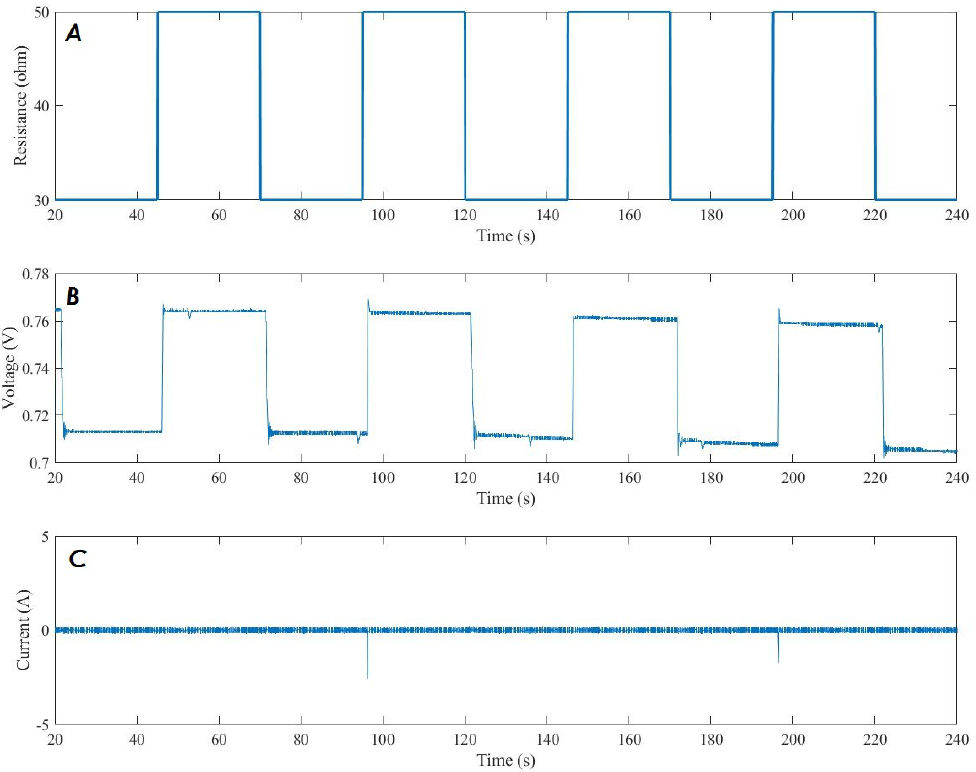
Figure 16. Control results: ( A ) load variations; ( B ) duty cycle; ( C ) error signal.